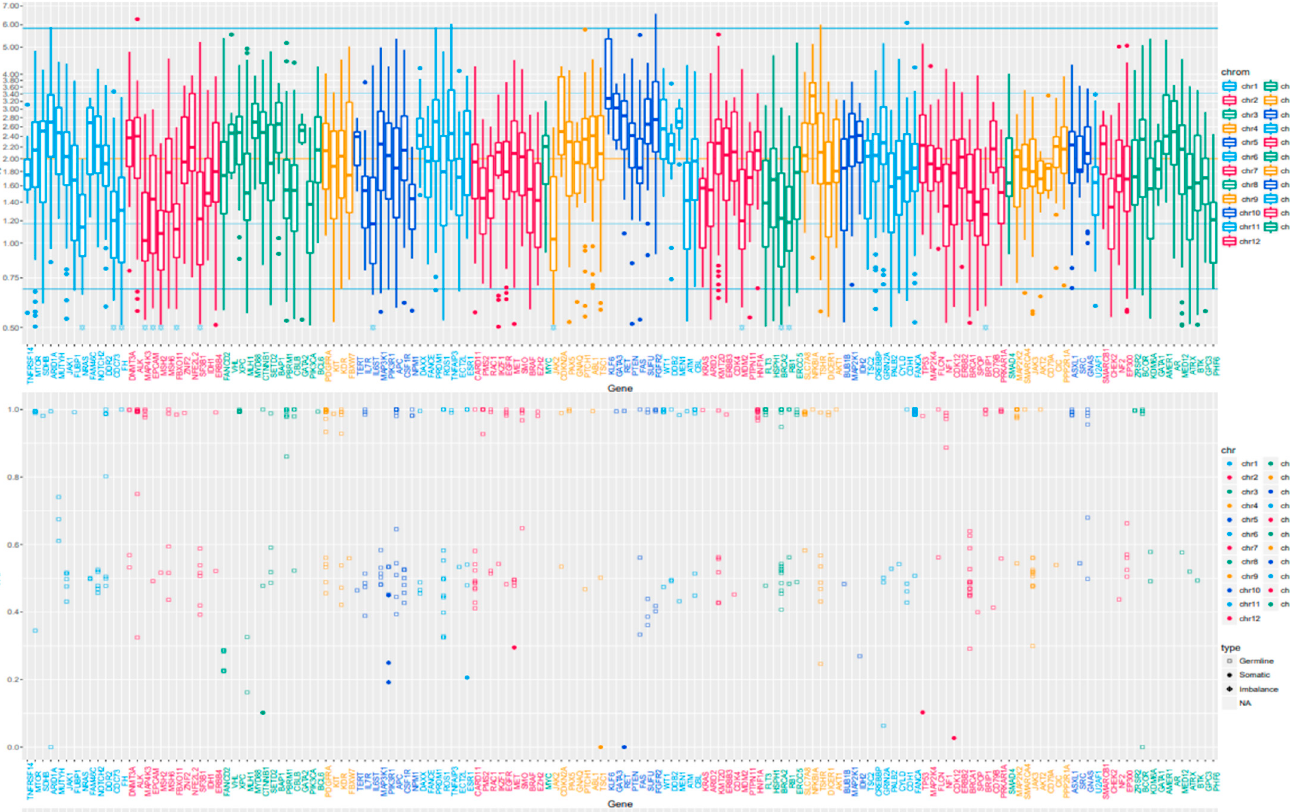
Figure 6. Copy number plots of the uterine tumor in the current case. The horizontal axis shows the chromosome location, and the vertical axis shows the gene copy number. The representative copy number plot appears normal. Table 1. Actionable variants in the uterine tumor.